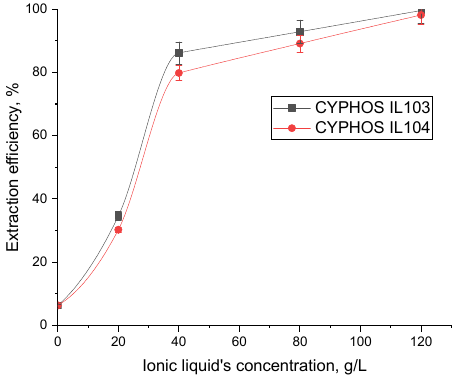
Figure 5. Ionic liquid concentration influence on extraction efficiency (initial phase pH = 4).